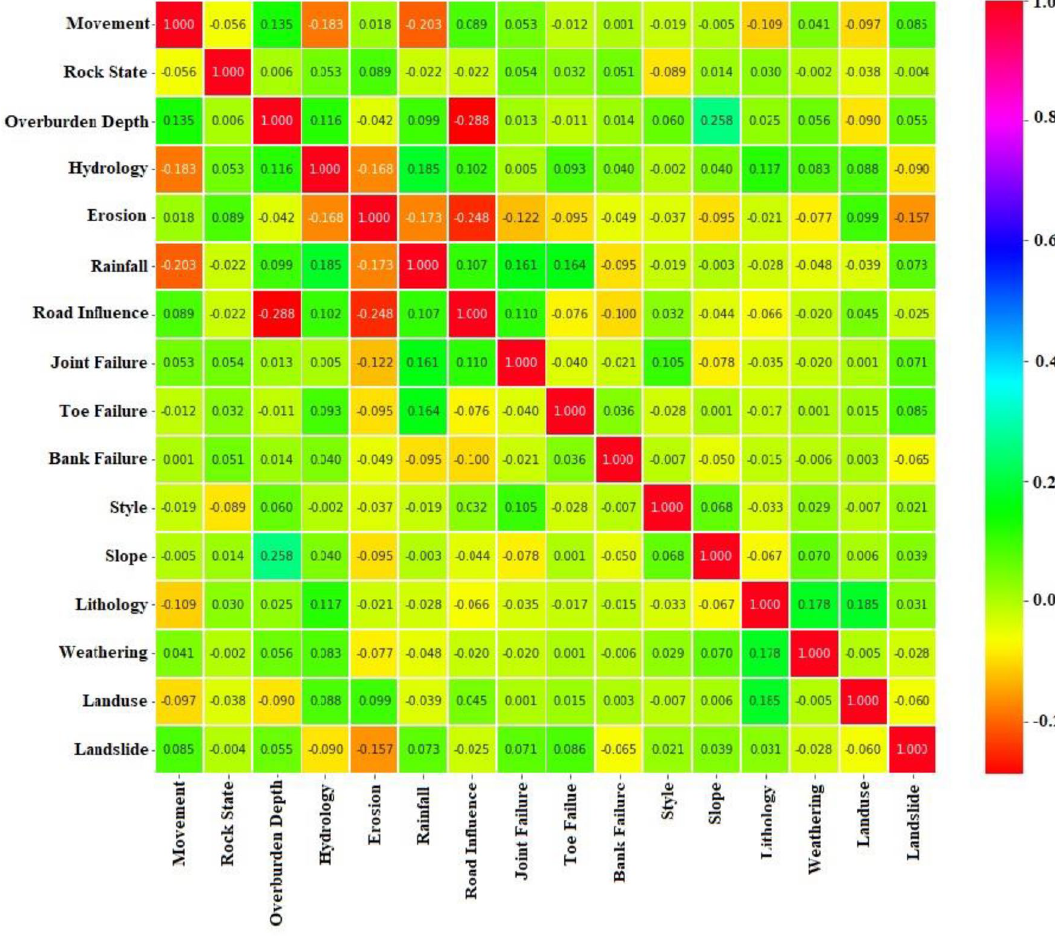
Figure 6. Heat map showing correlation matrix of landslide conditioning factors (LCFs). The color bar value of the right bar from high to low represent how closely the factors are using 150 estimators, HXGBRS achieved the highest accuracy using 60 estimators and HRFRS achieved highest accuracy using 110 estimators. Models validation and comparison. To improve the prediction capability of the landslide models, five hybrid ML approaches were implemented: Random Forest based Rough Set (HRFRS), Bagging based Rough Set (HBRS), XGBoost based Rough Set (HXGBRS), BPNN based Rough Set (HBPNNRS), and Bayesian Network based Rough Set (HBNRS). These hybrid models were constructed by combining the Rough set model with indi- vidual empirical methods. The rough set model is useful for identifying the optimized landslide patterns. These optimized patterns were utilized by individual empirical models for the training purpose of the model. The final model for landslide prediction in this work will be a hybrid method with the best prediction capabilities. The confusion matrices for the developed models using training and testing dataset is shown in Fig. 7. The overall performance of the five approaches was evaluated using five statistical indicators (sensitivity, specificity, precision, accuracy, and F1-Score) and the AUROC curves as shown in Fig. 8. ROC curves have been employed in landslide hazard evaluation by a large number of researchers 130–133. The prediction accuracy of all models was measured using ROC in this study. The AUC of the ROC curve was calculated using training and testing datasets. The performance of the models showed acceptable outcomes as shown in Fig. 8. In both the training and testing datasets, the HXGBRS model obtained the highest AUC values. The AUC values for the HXGBRS model were determined to be (0.937), respectively, for the testing dataset followed by HBPNNRS (0.924), HRFRS (0.904), HBRS (0.894), and HBNRS (0.883) respectively listed in Table 5. All of the models, however, produced reasonable results and showed to be promising solutions for predictive modeling in the region under investigation. Additionally, the models were compared and evaluated using five statistical estimators (accuracy, sensitivity, specificity, precision, and F1-score) listed in Tables 4 and 5. The results of the study revealed that the HXGBRS model had the highest accuracy, precision, and F1-Score values (89.92%, 0.946, and 0.926), followed by HRFRS (88.48%, 0.936, and 0.916), HBRS (88.48%, 0.925 and 0.915), HBPNNRS (87.00%, 0.905 and 0.895), and HBNRS (75.50%, 0.851 and 0.824) respectively. Furthermore, the HXGBRS model gained the highest specificity (0.878)